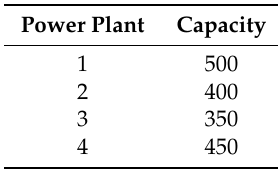
Table 2. Power generation capacity of power plants (MW).